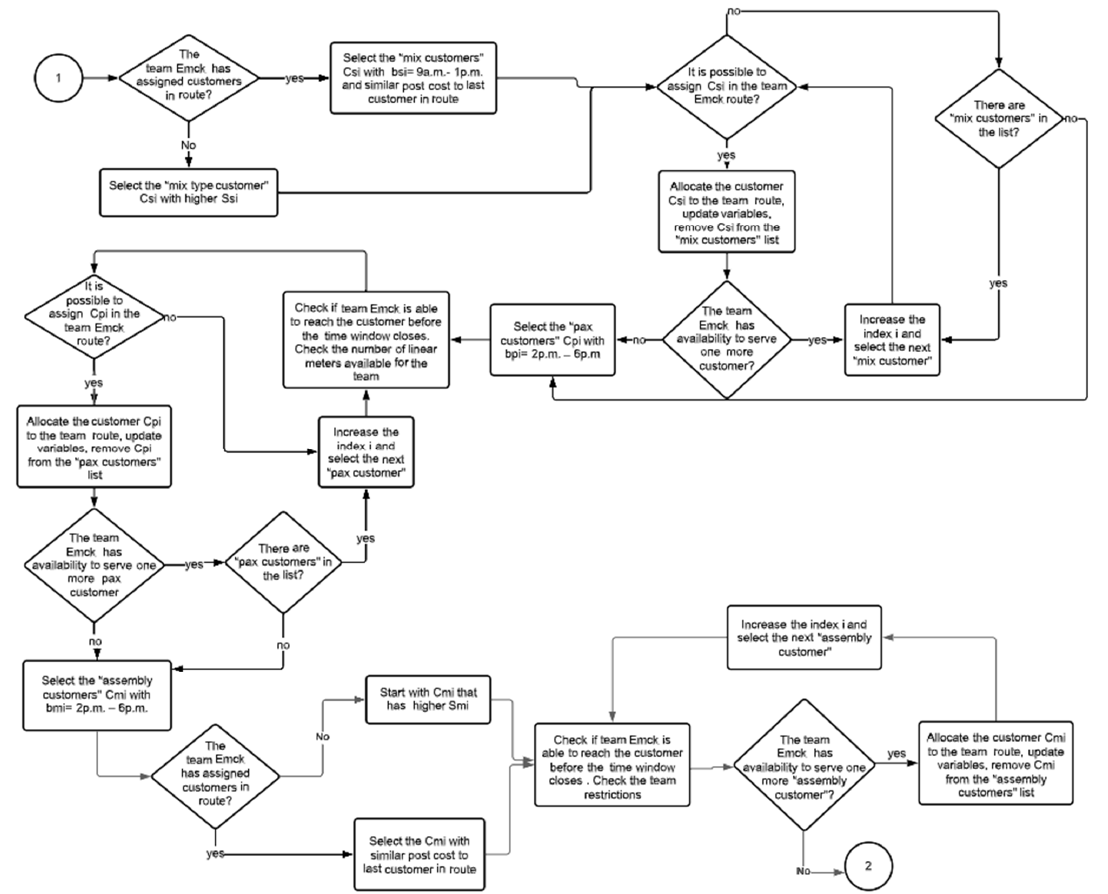
Figure 2. Heuristics graphic display.